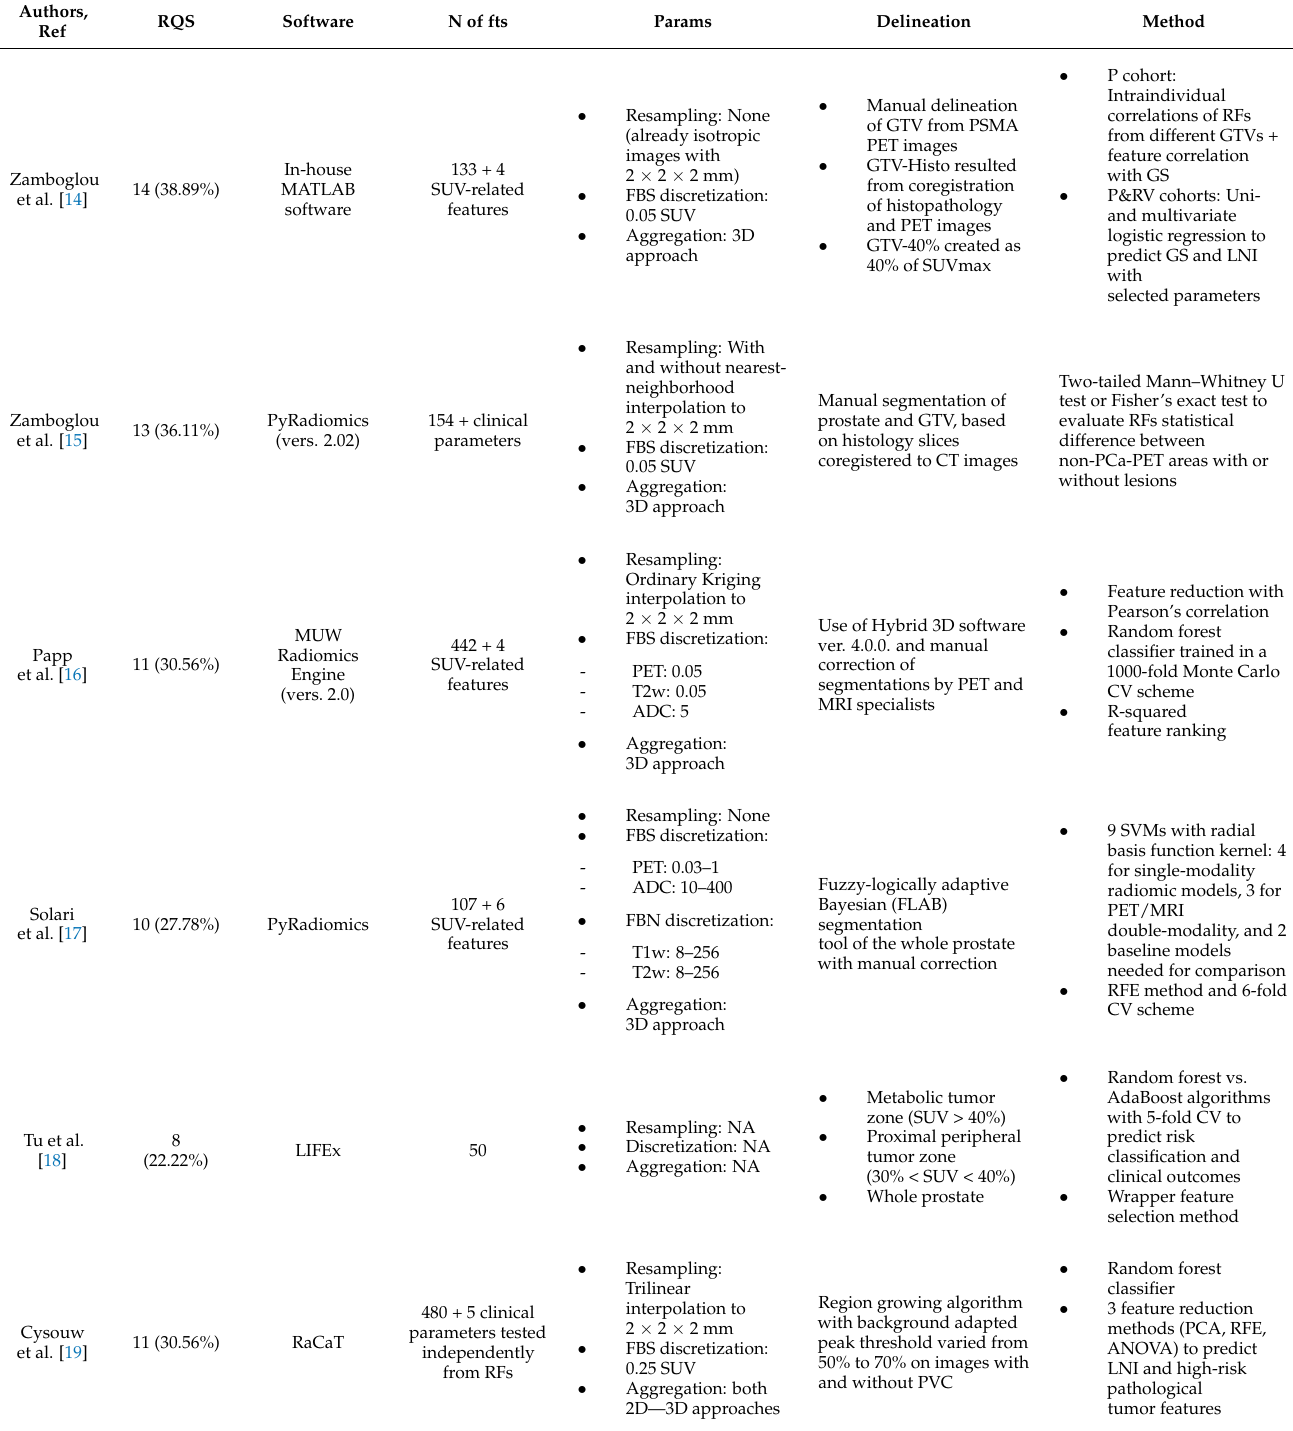
Table 2. Radiomic analysis of the selected